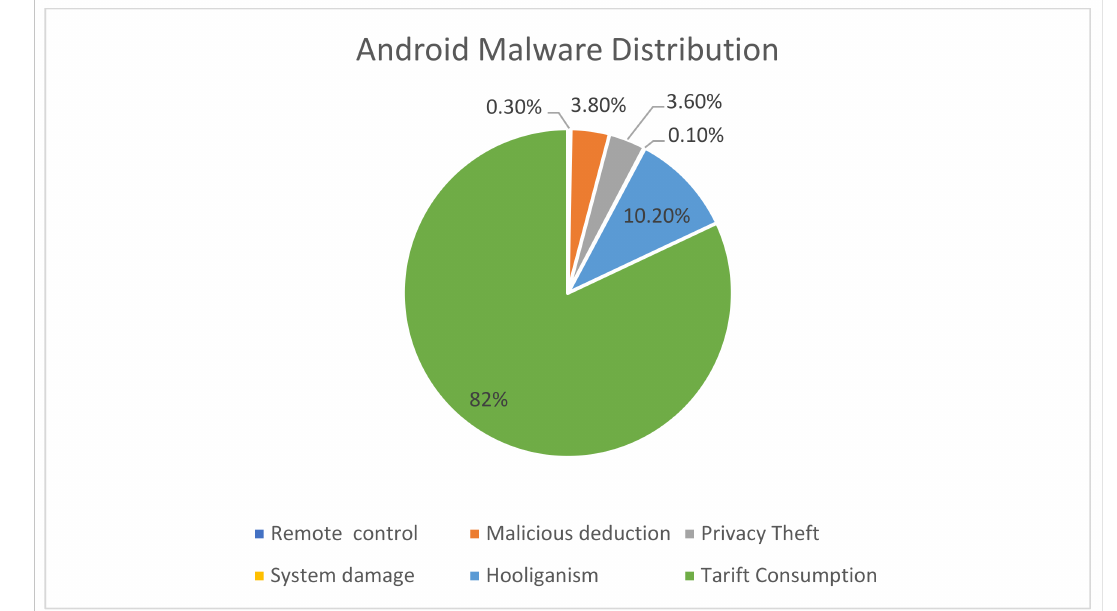
Figure 2. Percentage of Android malware